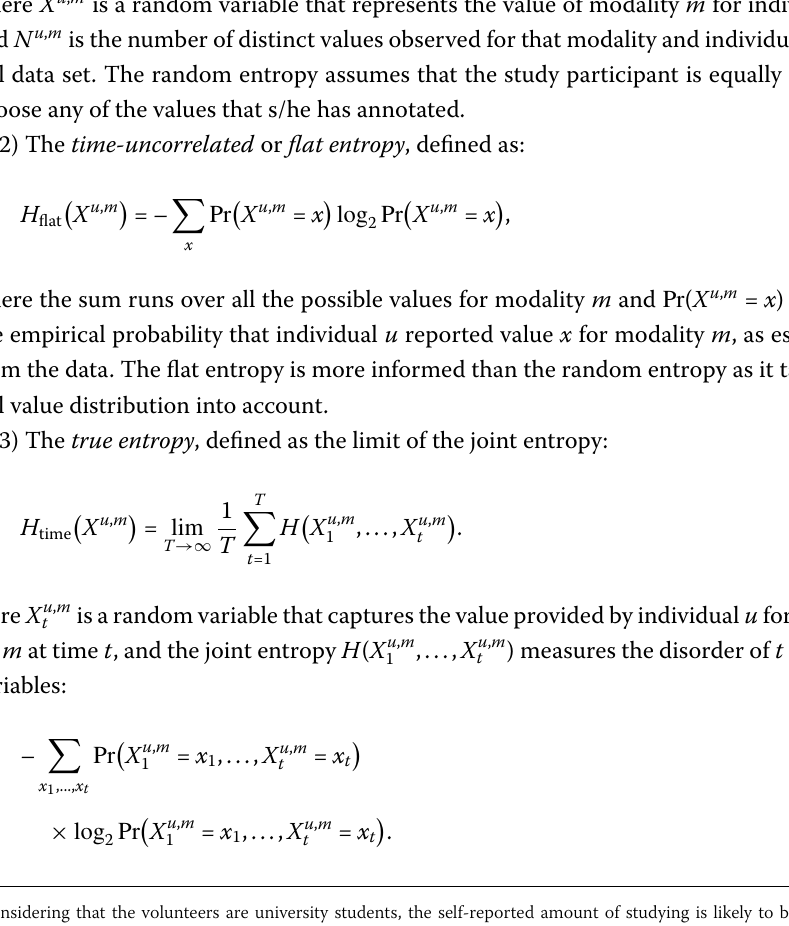
figure. The profile transpiring from the data reflects the source demographics. 1 The con- centration of mass on few preferred values is consistent with previous studies on mobility [3,